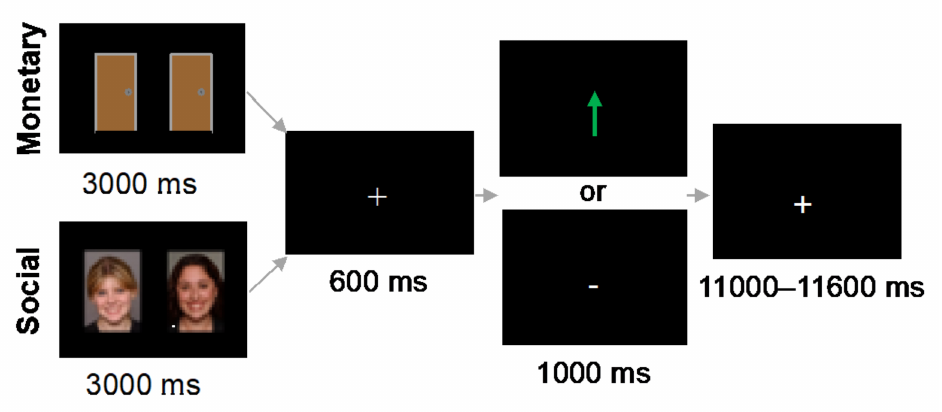
Figure 1. fMRI-based monetary and social reward